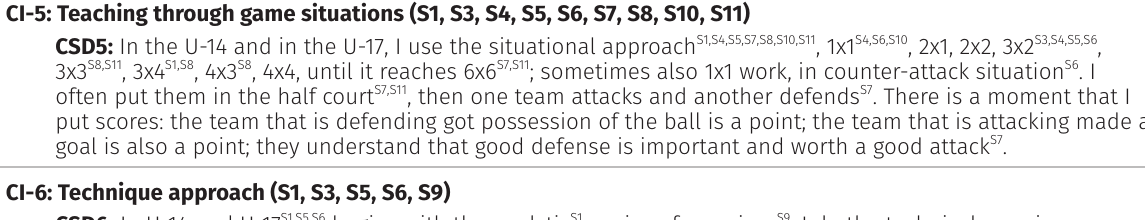
Table IV. CSD referring to the teaching of individual defensive content in U-14 and U-17 teams. CI-5: Teaching through game situations (S1, S3, S4, S5, S6, S7, S8, S10, S11) CSD5: In the U-14 and in the U-17, I use the situational approach S1,S4,S5,S7,S8,S10,S11 , 1x1 S4,S6,S10 , 2x1, 2x2, 3x2 S3,S4,S5,S6 , 3x3 S8,S11 , 3x4 S1,S8 , 4x3 S8 , 4x4, until it reaches 6x6 S7,S11 ; sometimes also 1x1 work, in counter-attack situation S6 . I